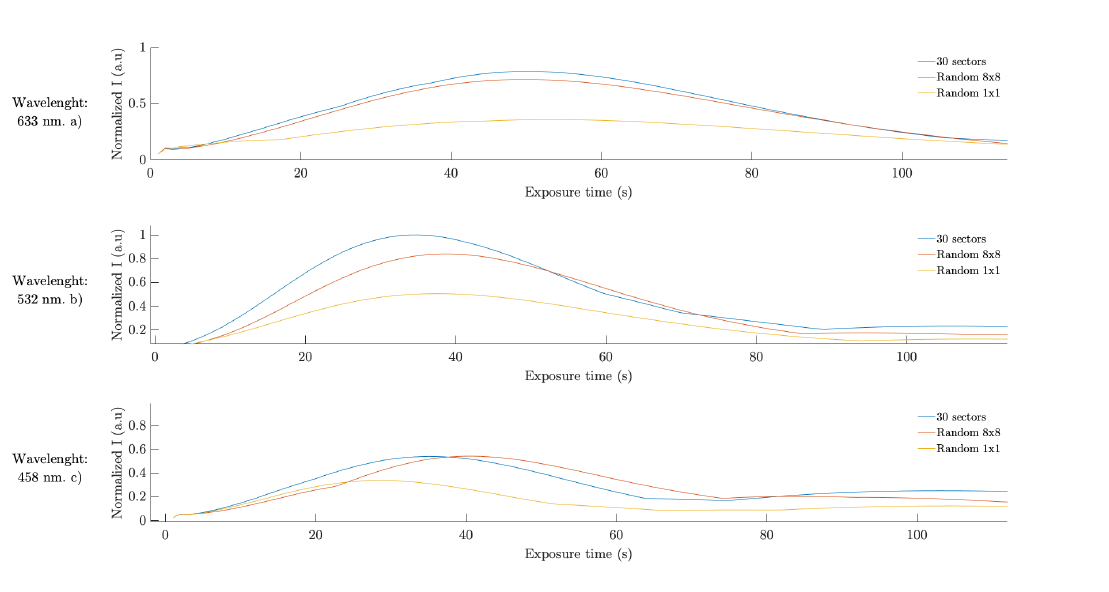
Figure 12. Simulated normalized intensity as a function of recording time at the focal point for different wavelength illumination. ( a ) 633 nm; ( b ) 532 nm and ( c ) 458